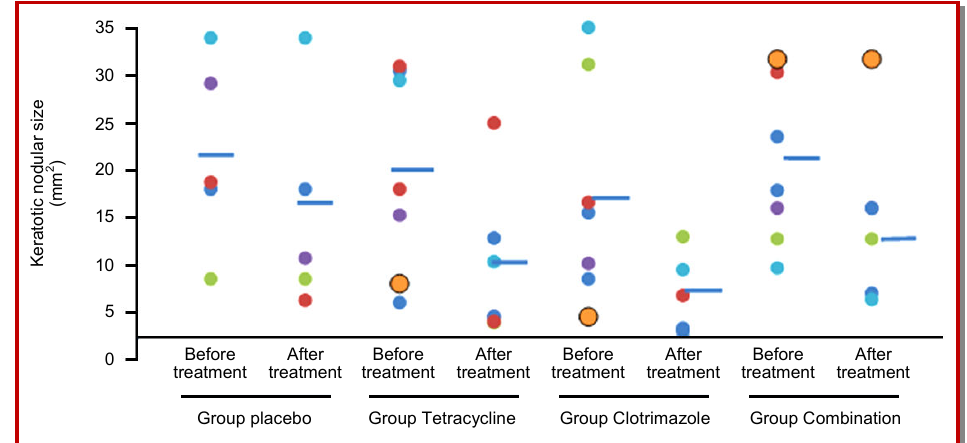
Figure 4: Changes of keratotic nodular size before and after treatment